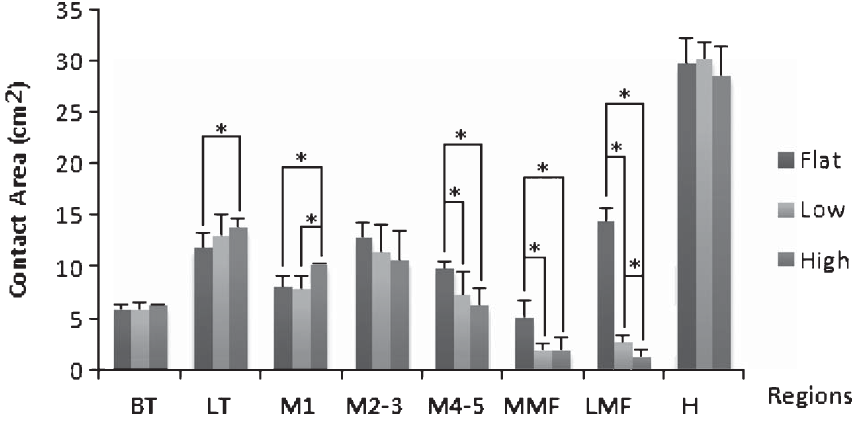
Fig. 5. Contact area during jogging with different heel heights. ∗ indicates significant difference ( p <0.05). pressure, force-time integral, and contact area under the forefoot surface (BT, OT, M1, M2-3 and M4-5 regions) during jogging. All the measured parameters except the contact area value were increased in the medial forefoot but decreased in the lateral